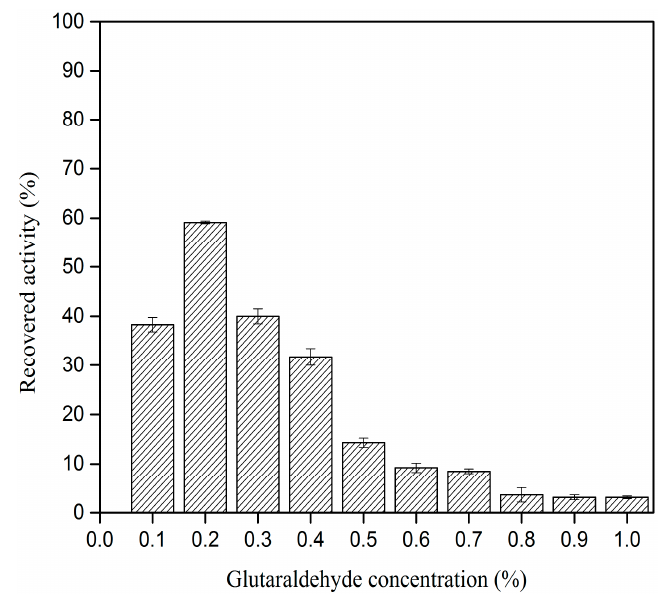
Figure 1. Effect of glutaraldehyde concentration on the recovered activity of cross–linked enzyme aggregate (CLEA)–elastase. Different concentrations of glutaraldehyde were added into aliquots of aggregated free elastase prior to incubation at 4 °C for 2 h with a rotating motion. The experiment was conducted in triplicate and the recovered activities are presented as mean values ± standard error.